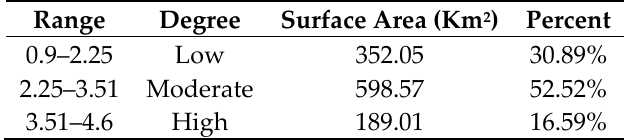
Table 3. Surface area and percentage by degree of susceptibility to